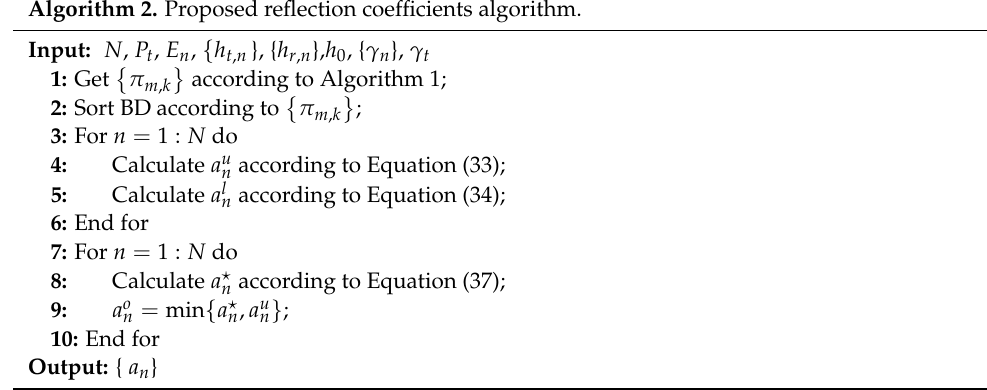
Algorithm 2. Proposed reflection coefficients